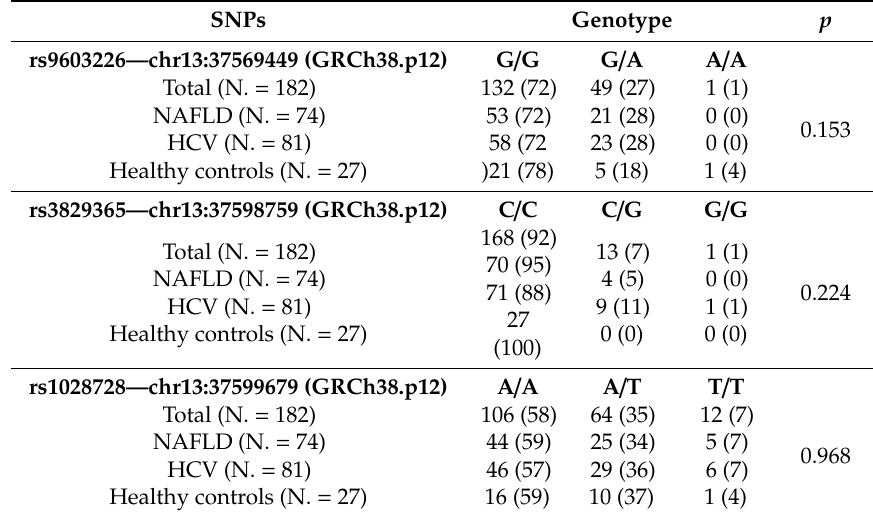
Table 5. Distribution of POSTN gene polymorphisms in the total studied population and in the three distinct groups. Data are presented as frequencies (%). The p value refers to the comparison between genotypes in the di ff erent study groups.